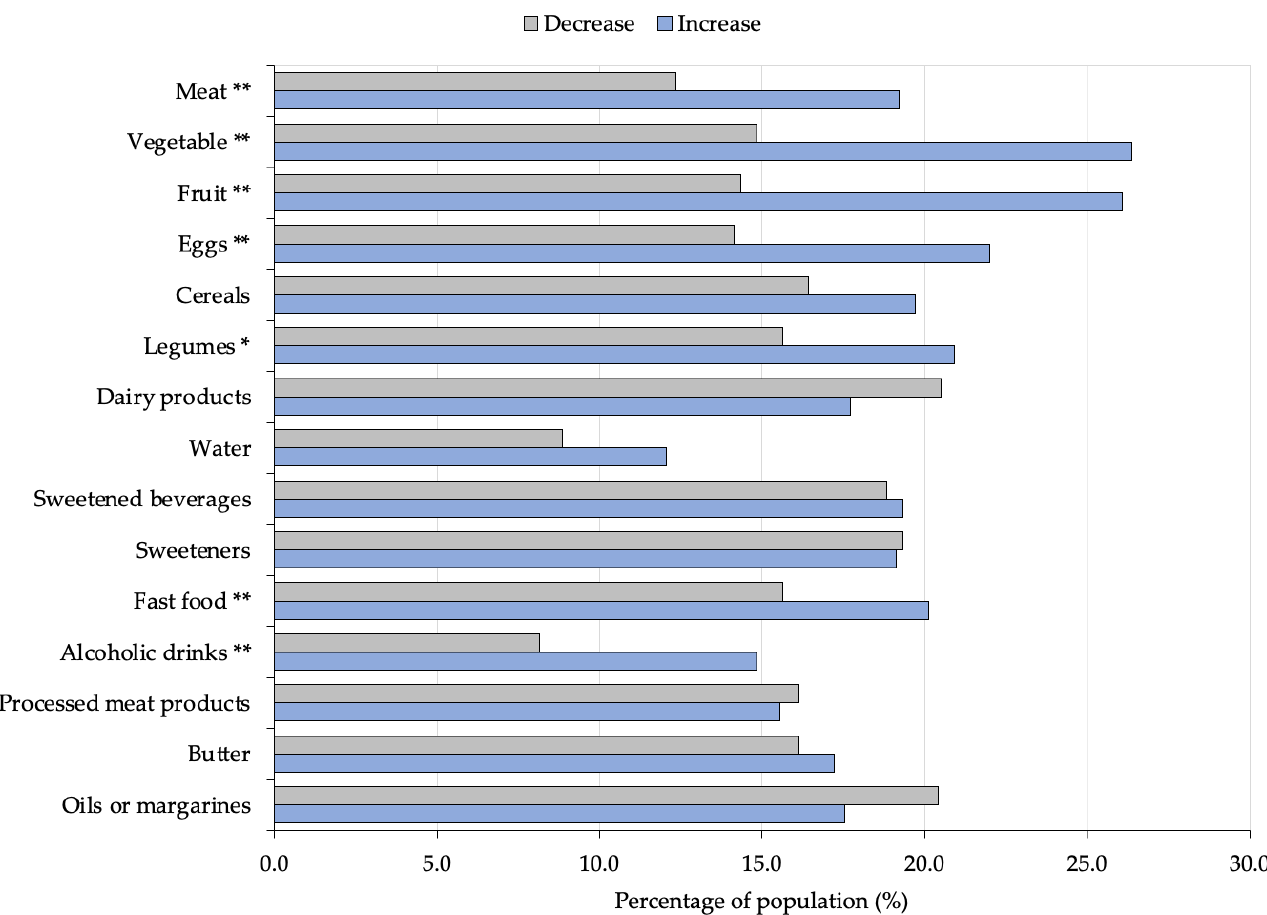
Figure 2. Percentage of population that reported a variation (increase or decrease) in the intake of each foodstuff during the COVID-19 lockdown. People who reported no change in the frequency of consumption are not represented in this figure. Statistically significant differences between food intake before and during the COVID-19 lockdown period were assessed by a Wilcoxon test and are indicated with asterisks (* p < 0.05; ** p < 0.001).